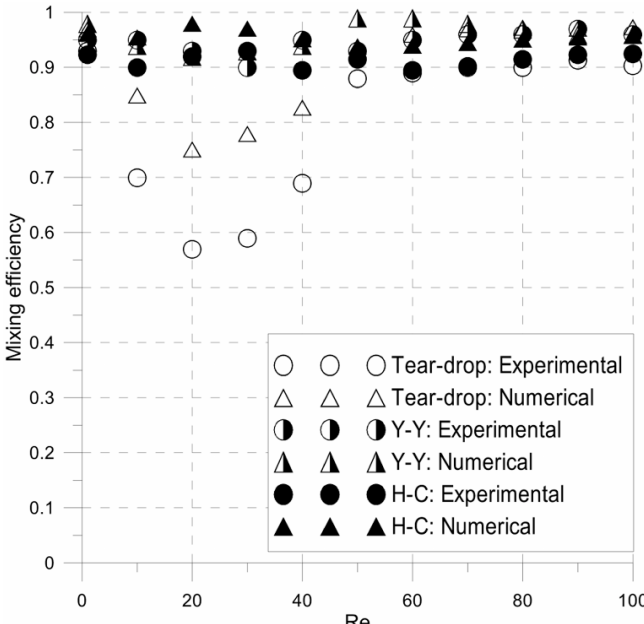
Figure 8. Experimental and numerical mixing efficiency of the Tear-drop, the Y-Y and the H-C mixers after four elements, varying Reynolds numbers.